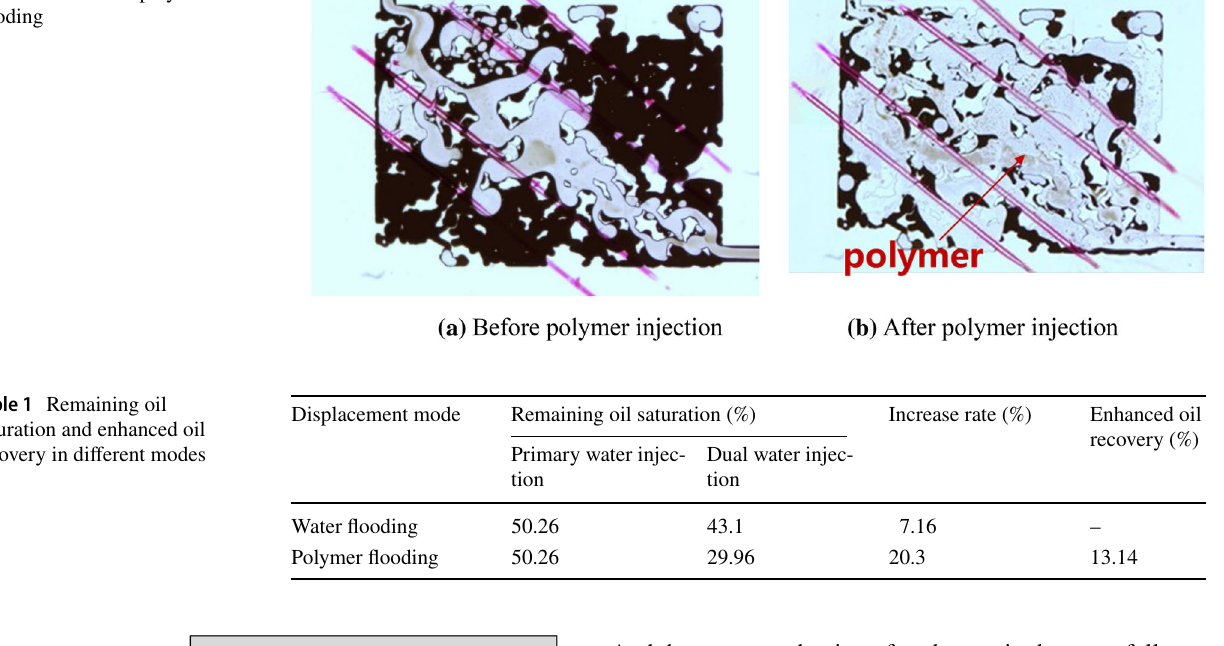
Fig. 2 Changes of residual oil before and after polymer flooding